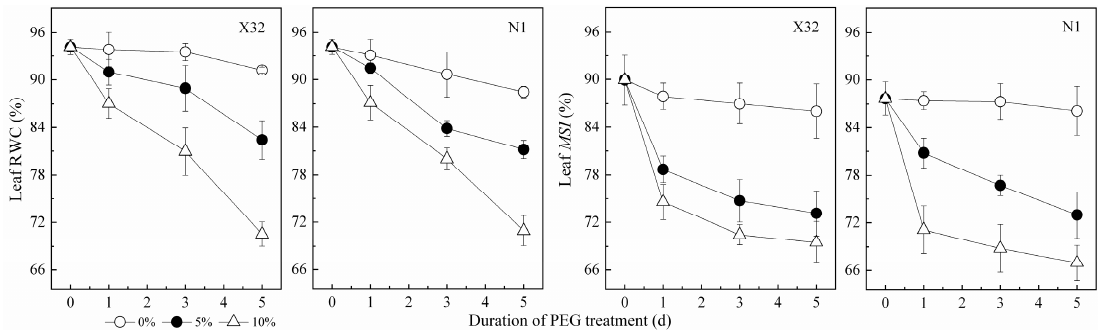
Figure 1. Effects of drought stress on relative water content (RWC) and the membrane stability index (MSI) in sweet potato leaves. X32 and N1 represent Xushu 32 and Ningzishu 1, respectively.